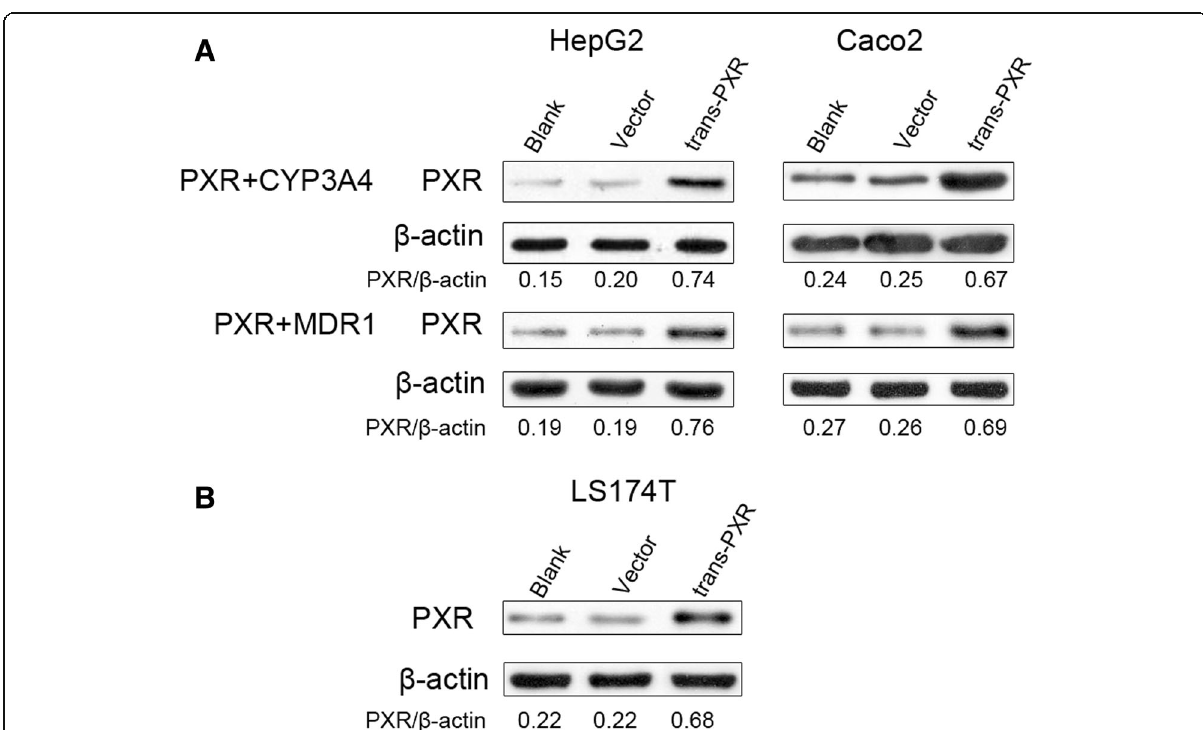
Fig. 2 The expression of PXR fusion protein in vitro was detected by Western blotting. a Blank: cells were non-transfected, Vector: cells were transfected with 600ng CYP3A4 (or MDR1)+100ng pcDNA3.1+10ng PRL-SV40, trans-PXR: cells transfected with 600ng CYP3A4 (or MDR1)+100ng pcDNA3.1-PXR +10ng PRL-SV40. b Blank: cells were non-transfected, Vector: cells were transfected with 100ng pcDNA3.1+10ng PRL-SV40, trans-PXR: cells were transfected with 100ng pcDNA3.1-PXR+10ng